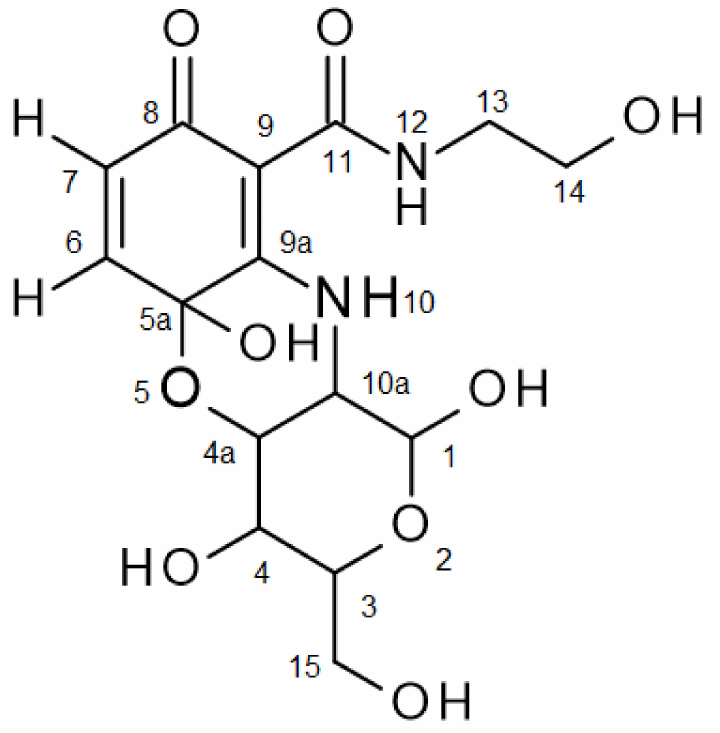
Figure 1. Product numbering of 3a .